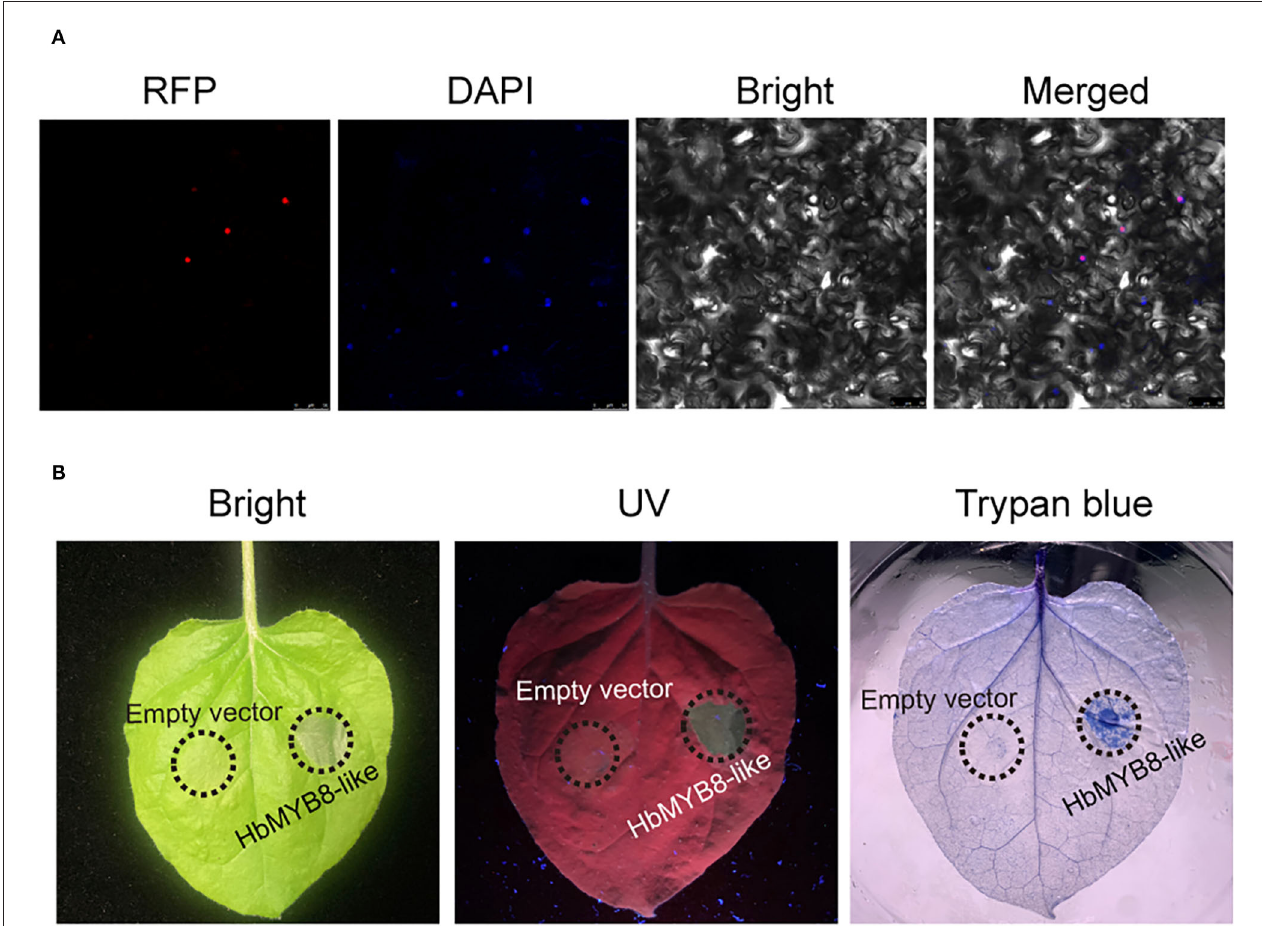
FIGURE 6 | HbMYB8-like localized on the nucleus and induced necrotic cell death. (A) Subcellular localization of HbMYB8-like protein in tobacco leaves. (B) Cellular necrosis induced by HbMYB8-like in tobacco leaves. Leaves were photographed under UV illumination (right) and normal light